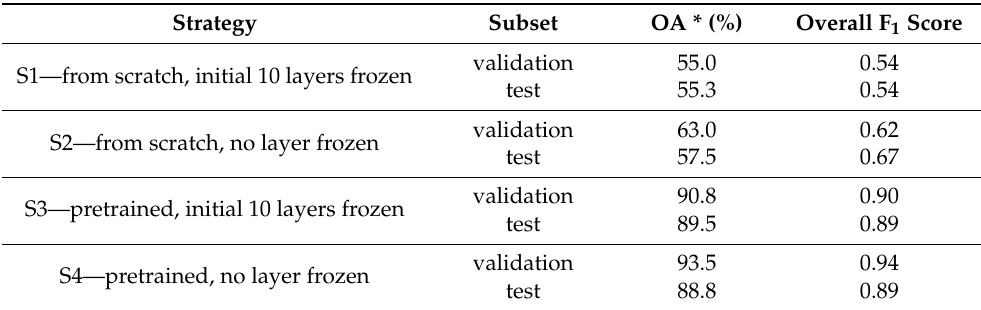
Table 6. Assessment results of different training strategies for deep learning.